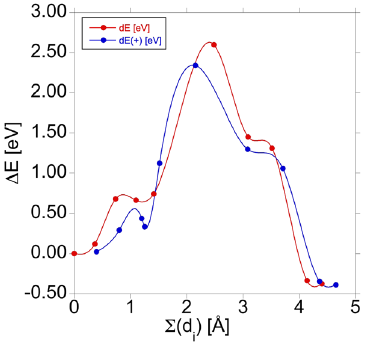
Fig. 5 | The change of the total energy during the transformation of the A - con fi guration into the C - con fi guration in the neutral (red curve) and in the positive(bluecurve)chargestate. Thecon fi gurationcoordinateisthesumofthe distances the interstitial carbon atom travels in the steps of the transformation.